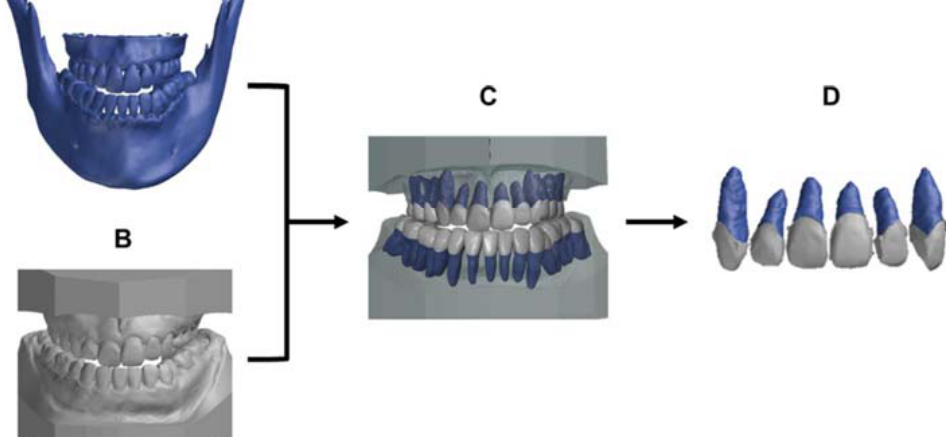
Figure 1. Protocol to generate the 3D digital crown/root models (3DCRM): ( A ), pre-movement CBCT image. ( B ), pre-movement scanned dental arches. ( C ), the pre-movement CBCT image was superimposed on the pre-movement scanned dental arches with the crown shape as an index. ( D ), the individual 3DCRMs of the six maxillary teeth were extracted from surrounding structures.